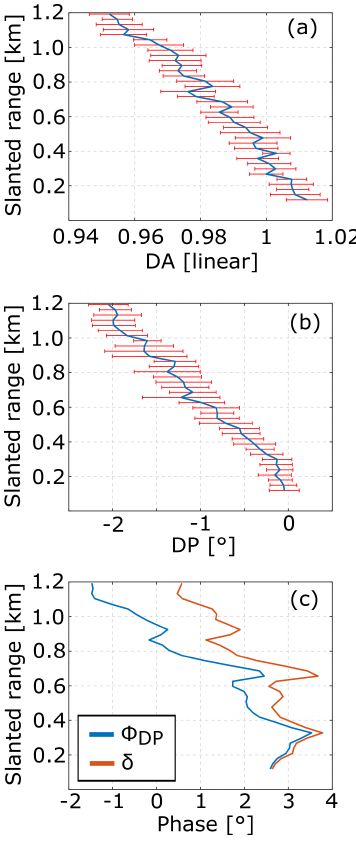
Figure 12. Profiles of differential attenuation or DA (a) and dif- ferential phase or DP (b) , which are solely due to propagational effects. The profiles have been derived using the spectral decom- position technique, illustrated in Fig. 11, applied to the profiles of spectra shown in Fig. 10. Blue lines and red bars indicate mean values and ± 1 standard deviation, respectively. Panel (c) shows the profiles of the differential phase (cid:56) DP (blue) and δ